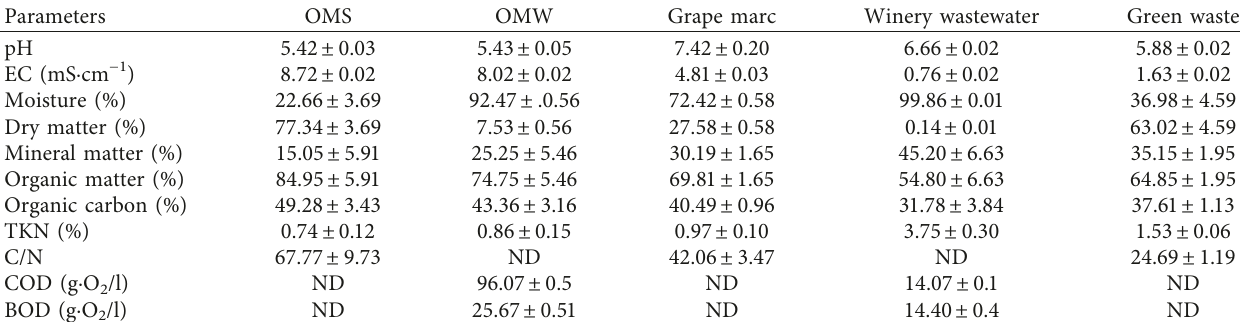
Table 1: Physicochemical characteristics of the raw materials used for composting process.